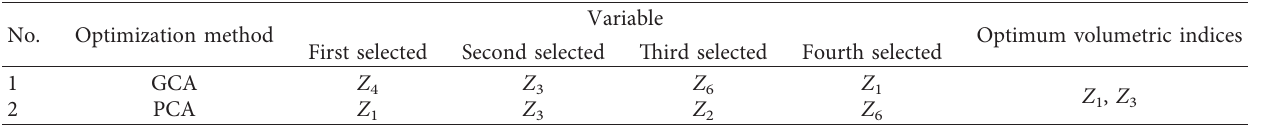
Table 10: Optimized volumetric indices.